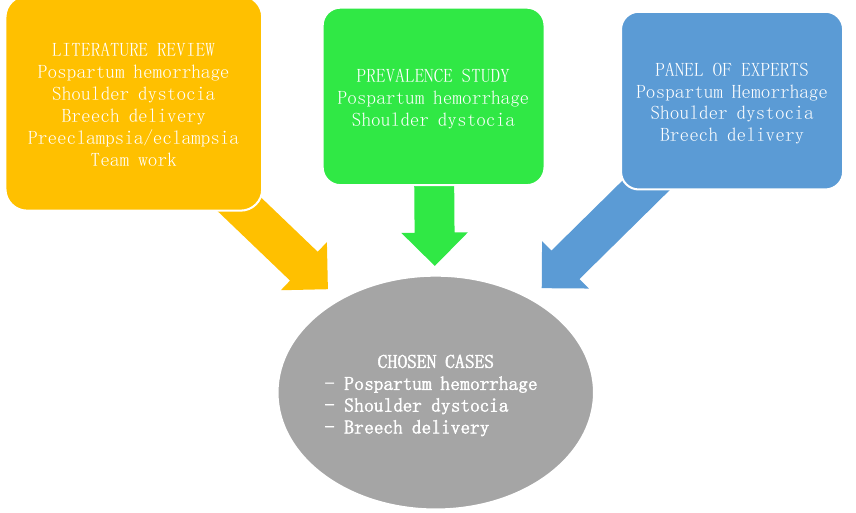
Figure 2. Summary of the results from the first phase.